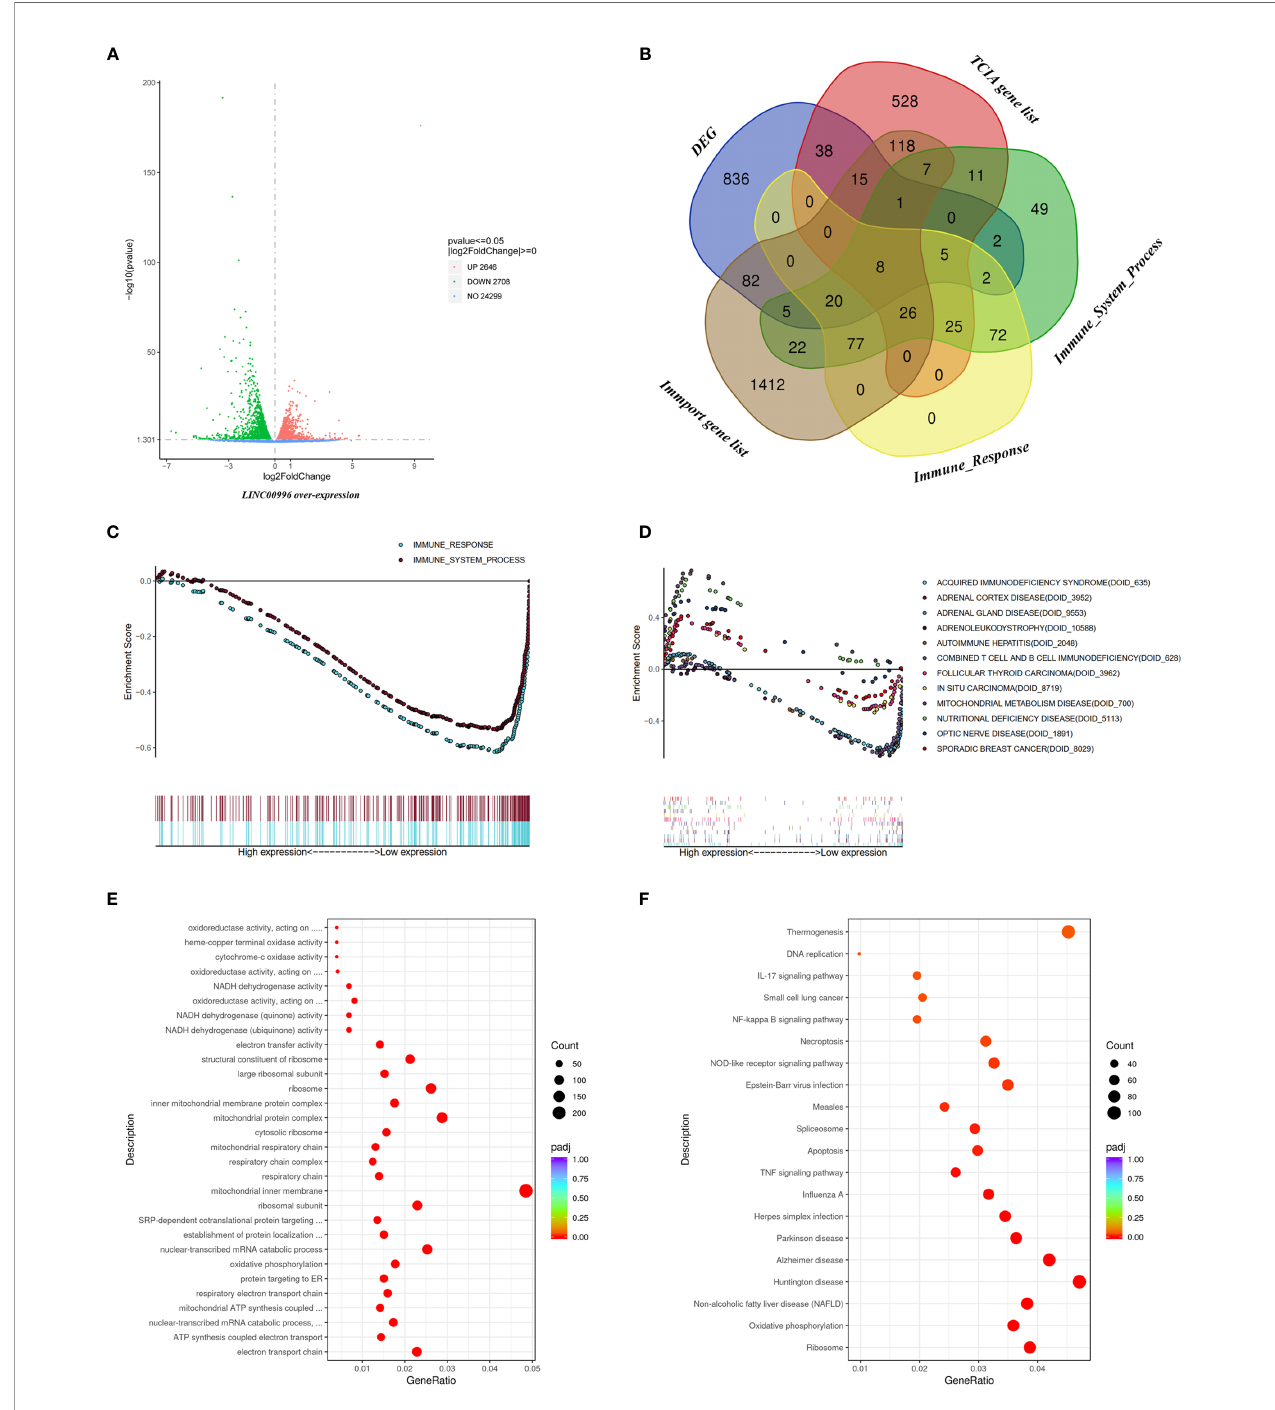
FIGURE 7 | Functional analysis based on RNA-seq data. (A) The DEGs between A549 with over-expressed LINC00996 and control group exhibited via Volcano diagram. (B) The intersection between DEGs, TCIA gene list, Immune_System_Process from GSEA, Immune_Response from GSEA and Immport gene list exhibited via Venn diagram. Enrichment analyses including immune-related gene sets (C) and Disease Ontology (D) via GSEA analysis, Gene Ontology (E) and Kyoto Encyclopedia of Genes and Genomes term (F) based on the DEGs between A549 with over-expressed LINC00996 and control